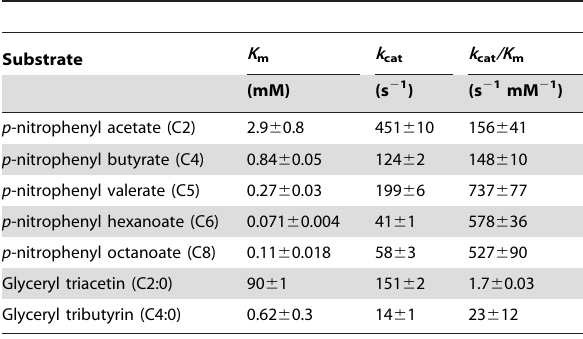
Table 2. Kinetic parameters of recombinant EstC toward p - nitrophenyl short chain esters and